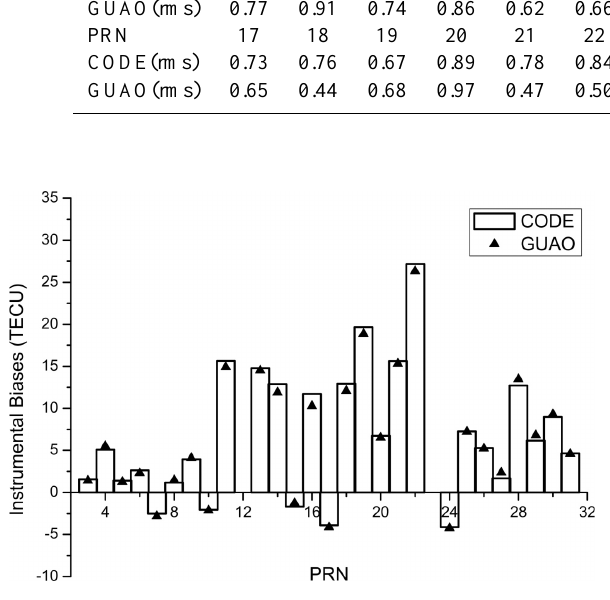
Fig. 1. Comparison of the instrumental biases issued by CODE with those estimated from GUAO data using the described method in